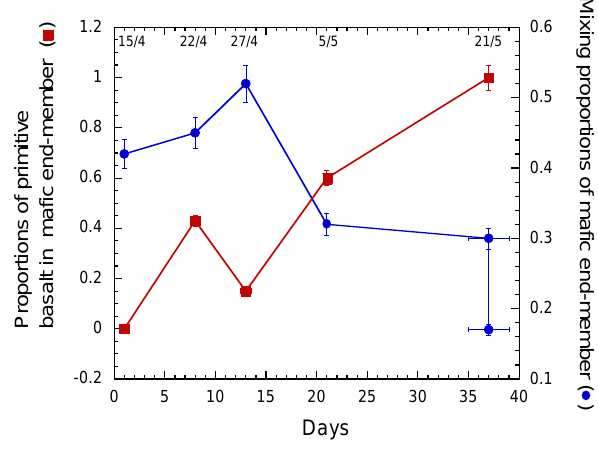
Fig. 5. Mixing (and mingling) proportions as a function of time of primitive basalt in the mafic end-member (scale on left y-axis) and that of basalt melt in the benmoritic tephra of Eyjafjallajökull. Fig. 5 Arbitrary 5% error is assigned to the estimated magma mixing pro- Sigmarsson et al. portions that are derived from Fig. (3). The decrease of the basalt component suggests that supply of silicic magma at depth is abun- dant (see text for further